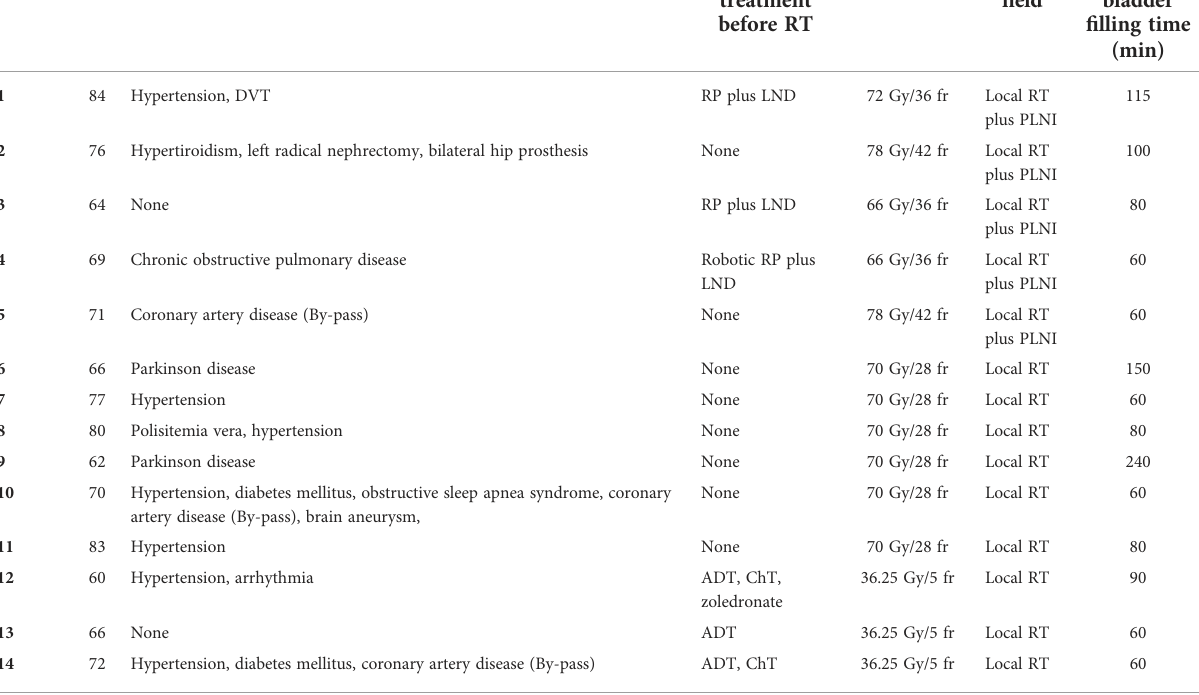
TABLE 2 Detailed summary of each patient ’ s demographics, disease characteristics, and treatment procedures. Patient Age Comorbidity